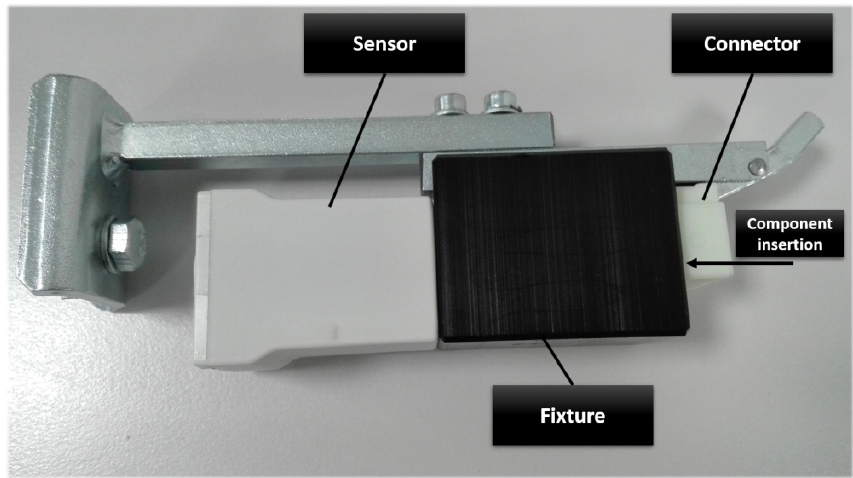
Figure 2. The designed connector fixture sends timestamps when the operator inserts a component into a fixture.